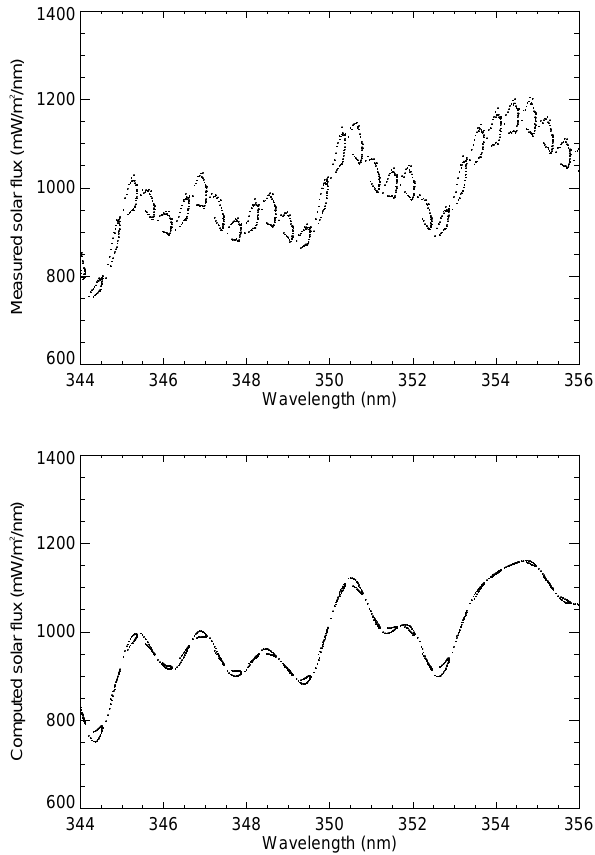
Figure 2. OMPS-measured solar flux (top) and high-resolution so- lar flux convolved with the measured OMPS NM bandpasses (bot- Fig. 2. OMPS-measured solar flux (top) and high resolution solar flux convolved with the measured OMPS tom). Dots are for different cross-track positions. Note that many NM band-passes (bottom). Dots are for different cross-track positions. Note that many dots (due to the spectral dots (due to the spectral smile) can fuse together to visually simu- smile) can fuse together to visually simulate a line. late a